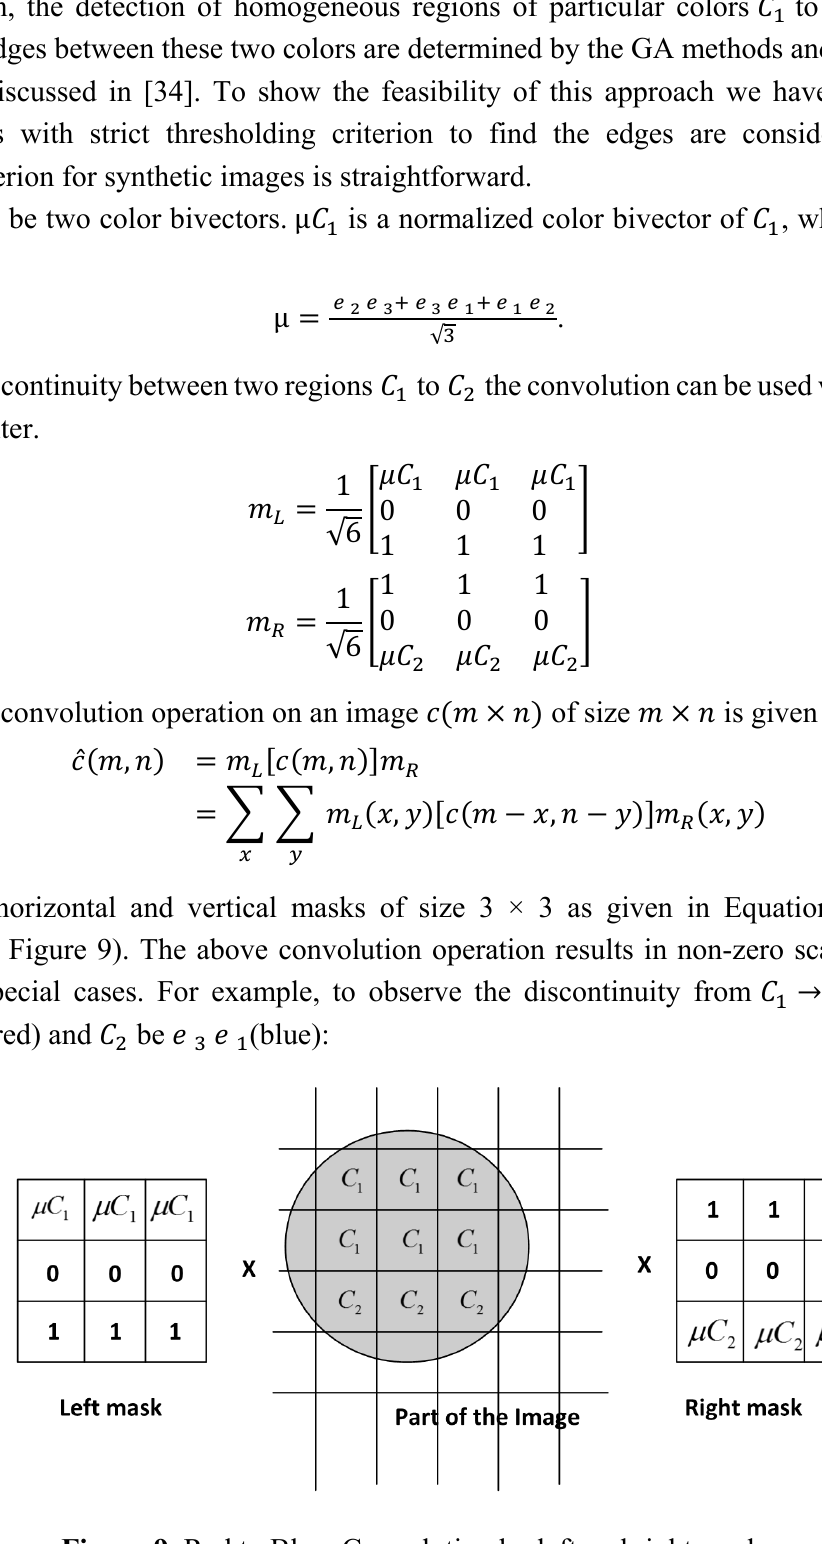
Figure 9. Red to Blue, Convolution by left and right